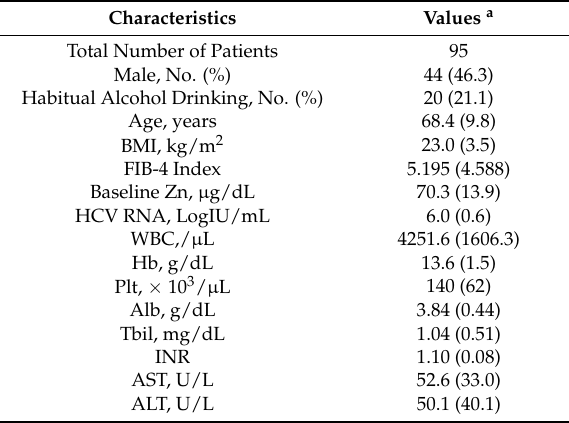
Table 1. Patient